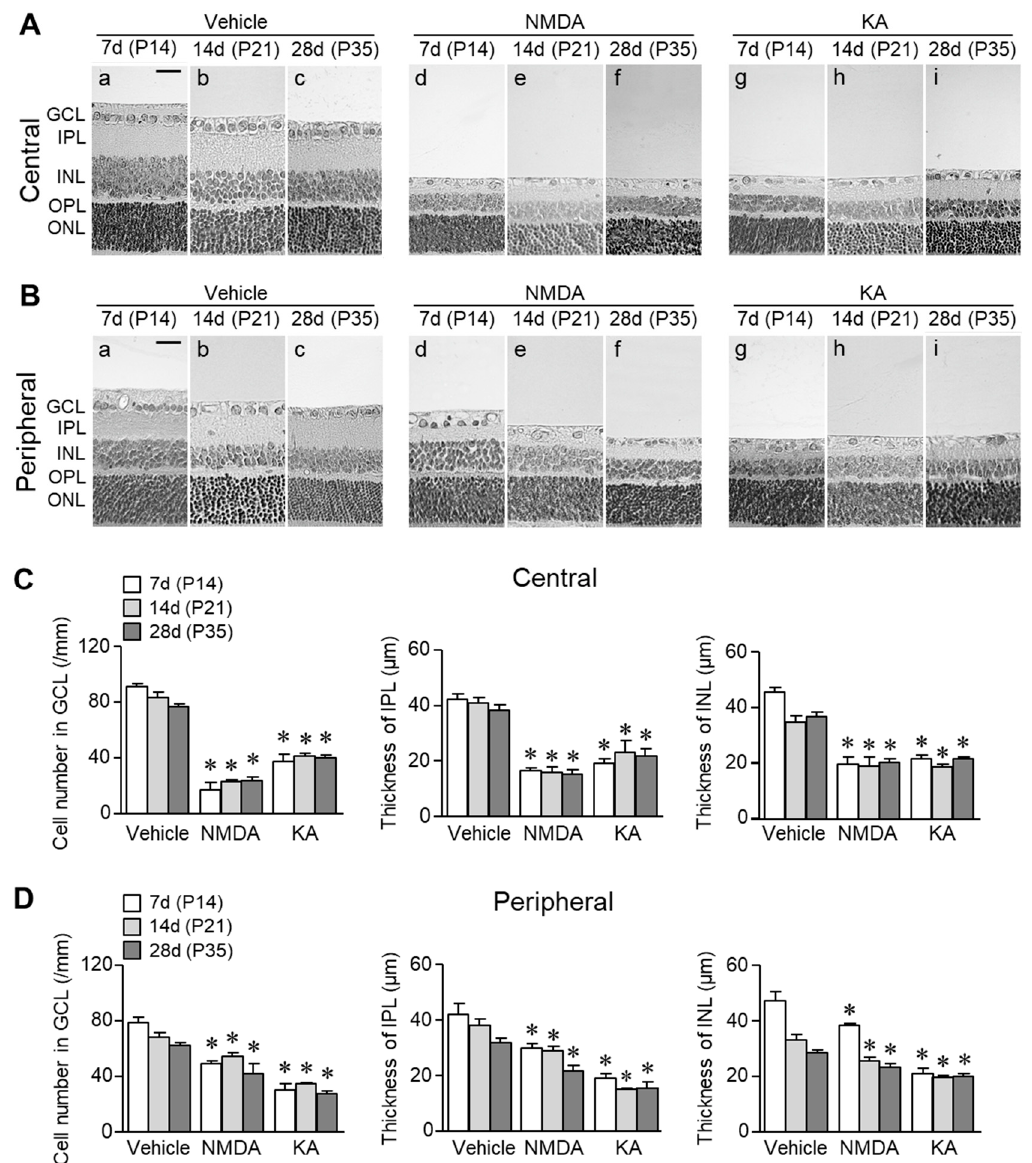
Figure 1. Changes in overall retinal morphology in rats intravitreally injected with NMDA or KA. ( A , B ) Representative photomicrographs of retinal cross-sections stained with hematoxylin and eosin obtained 7 (P14), 14 (P21), and 28 days (P35) following intravitreal injection of vehicle, NMDA (200 nmol) or KA (20 nmol) on P7. Scale bar = 50 µ m in panel a (applies to b–i). ( C , D ) Quantification of the number of cells in GCL and the thicknesses of IPL and INL in central ( C ) and peripheral ( D ) retinal areas. The number of cells in GCL was expressed per length of retina (in millimetres). * p < 0.05 vs. the corresponding age-matched control value (vehicle). n = 4–5.